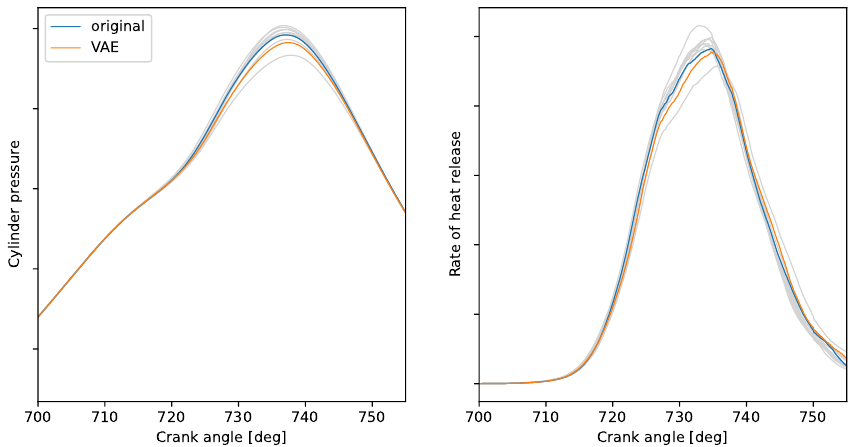
Figure 9. In-cylinder combustion process results of the common multicycle simulations and one artificial generated initialization set.